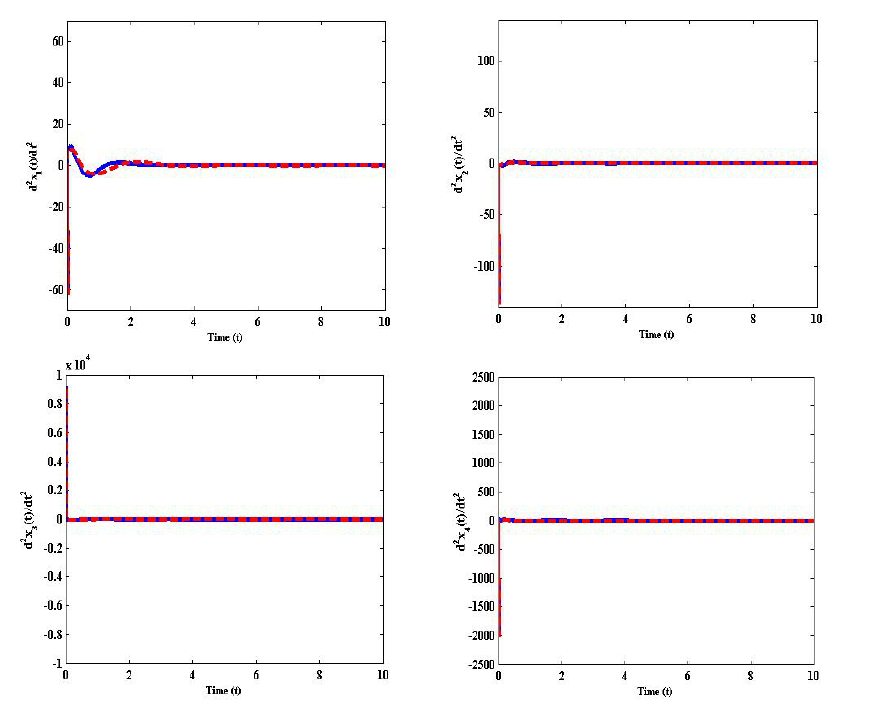
Figure 7. Acceleration trajectories of controlled and uncontrolled for helicopter system (20).